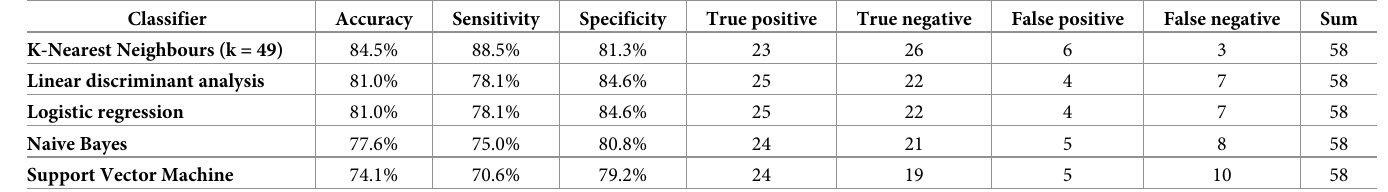
Table 5. Overall classification of subjects based on classification of individual steps and majority voting. Five highest performing classifiers were selected for compari- son of overall classification. Columns on the right side present the number of subjects classified in each category.